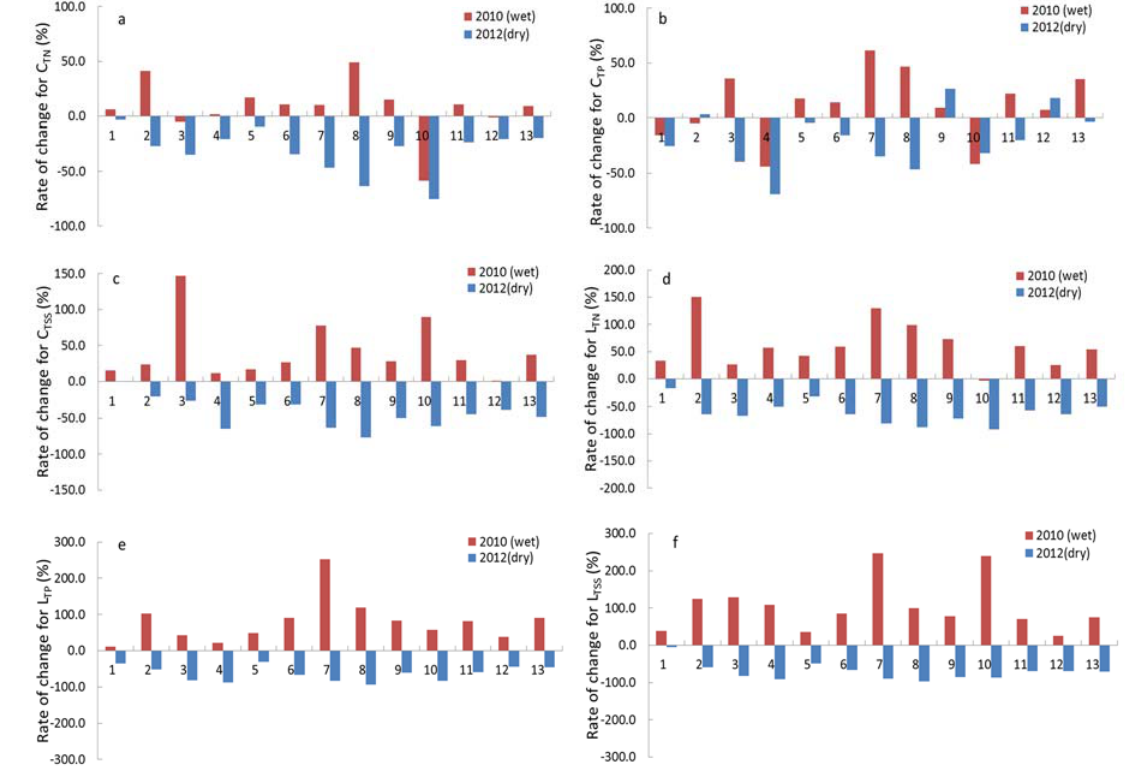
Figure 5. Relative changes in water quality concentrations and loads ( TN , TP , TSS ) in 2012 and 2010 compared to average values between 1995 and 2013: concentration of TN ( C TN ) ( a ); concentration of TP ( C TP ) ( b ); concentration of TSS ( C TSS ) ( c ); load of TN ( L TN ) ( d ); load of TP ( L TP ) ( e ); load of TSS ( L TSS ) ( f ). The number (1–13) in X ‐ axis denotes 13 watersheds: Twin Cities (1), Lower Minnesota (2), Turkey (3), Maquoketa (4), Copperas ‐ Duck (5), Lower Wapsipinicon (6), Skunk (7), Upper Iowa (8), Lower